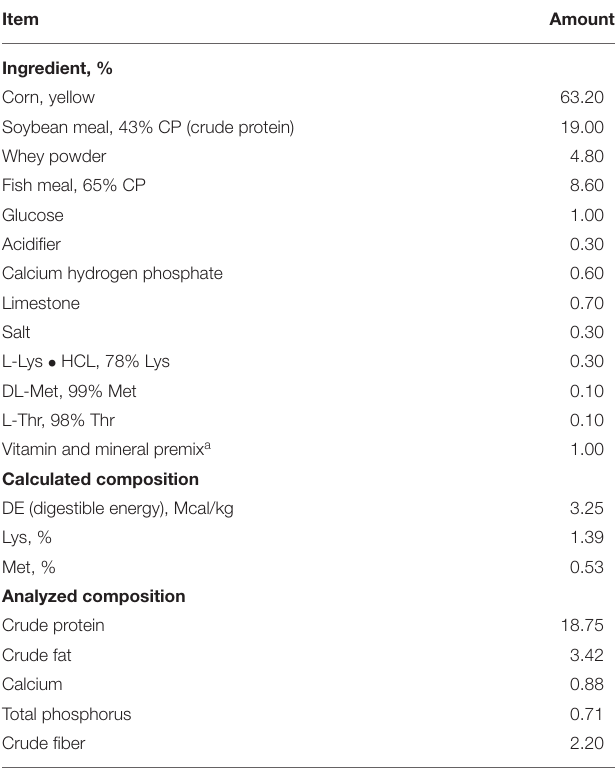
TABLE 1 | Ingredients and chemical composition of the basal diet (%w/w, as-fed basis) a